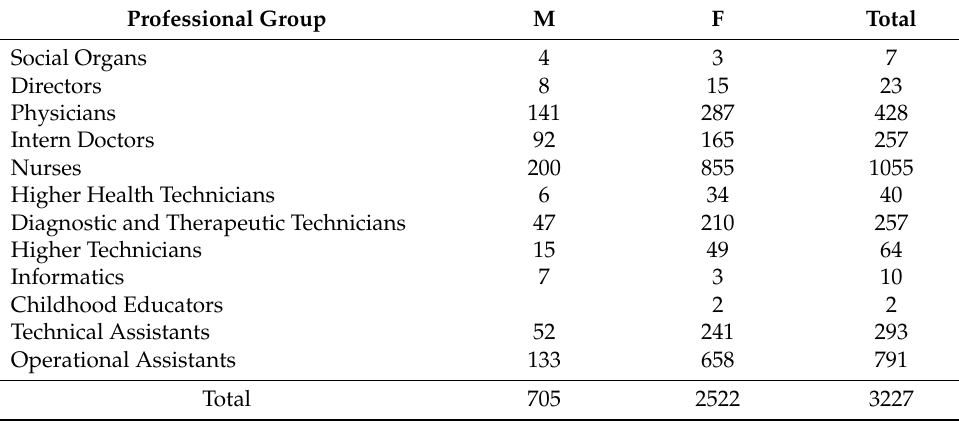
Table 1. Distribution of employees by gender and professional